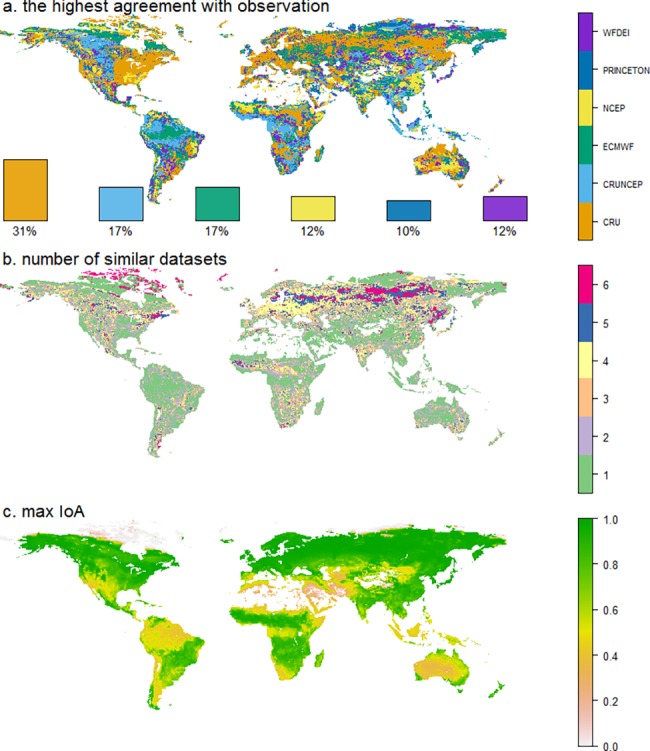
Global maps of climate dataset performance.Panel a) indication of which climate dataset is producing the highest Index of agreement (IoA; calculated at monthly scale) to JUNG11 (1982–2010). The bars show a global total fraction of vegetated grid cells for which the climate dataset is giving the highest IoA. Panel b) shows how many datasets producing GPP simulations with a similar agreement (within 5%) as the one identified in (a). Panel c) displays the maximum IoA between simulated GPP and JUNG11 for each grid cell.